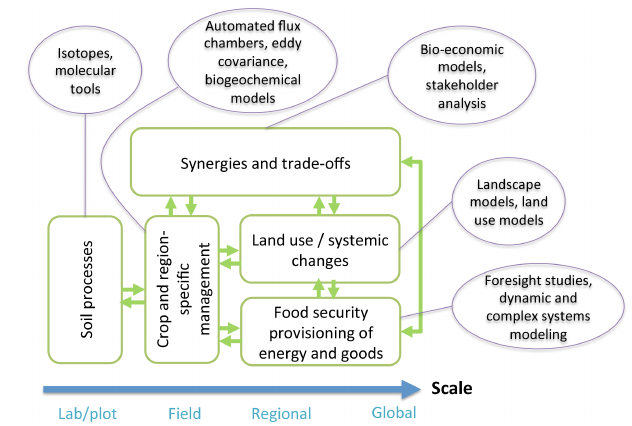
Figure 1. Illustration of interactions between major themes relevant for N 2 O mitigation from patching leaks to transformative action. Examples of research tools commonly associated with the different themes are shown in the round text